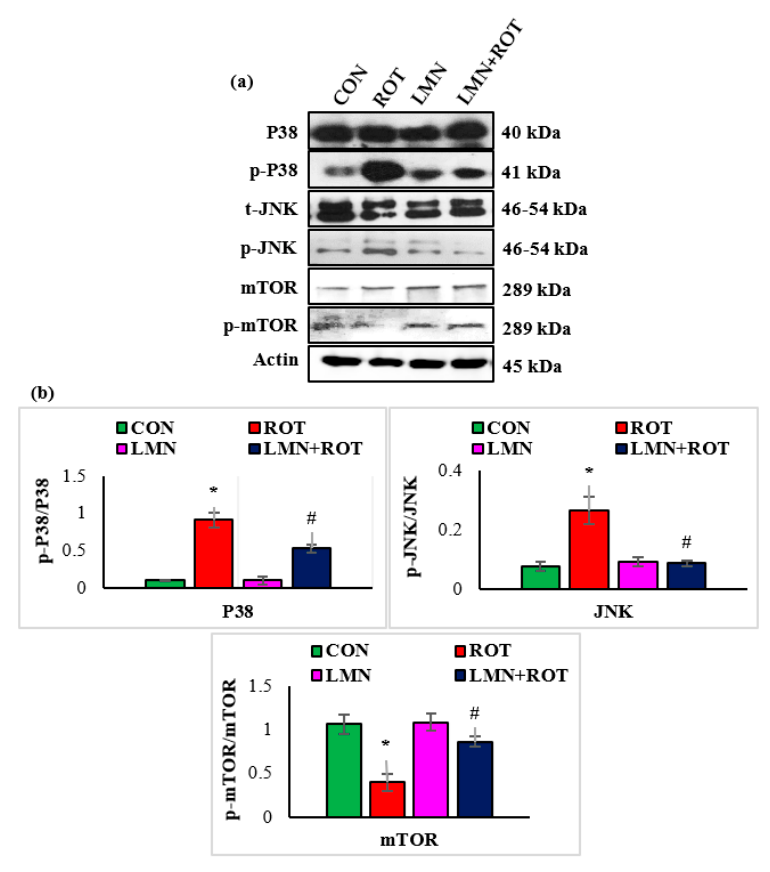
Figure 8. Effect of limonene on the protein expressions of P38, JNK, m-TOR, and p-m-TOR densito- metric analysis in the striatal tissues ( a , b ). Immunoblotting was performed in duplicate and the results are presented as mean ± SEM. * p < 0.05 CON vs. ROT; # p < 0.05 ROT vs. LMN + ROT (one-way ANOVA followed by DMRT). CON: normal control, ROT: rotenone, LMN: limonene, LMN + ROT: limonene and rotenone treatment.